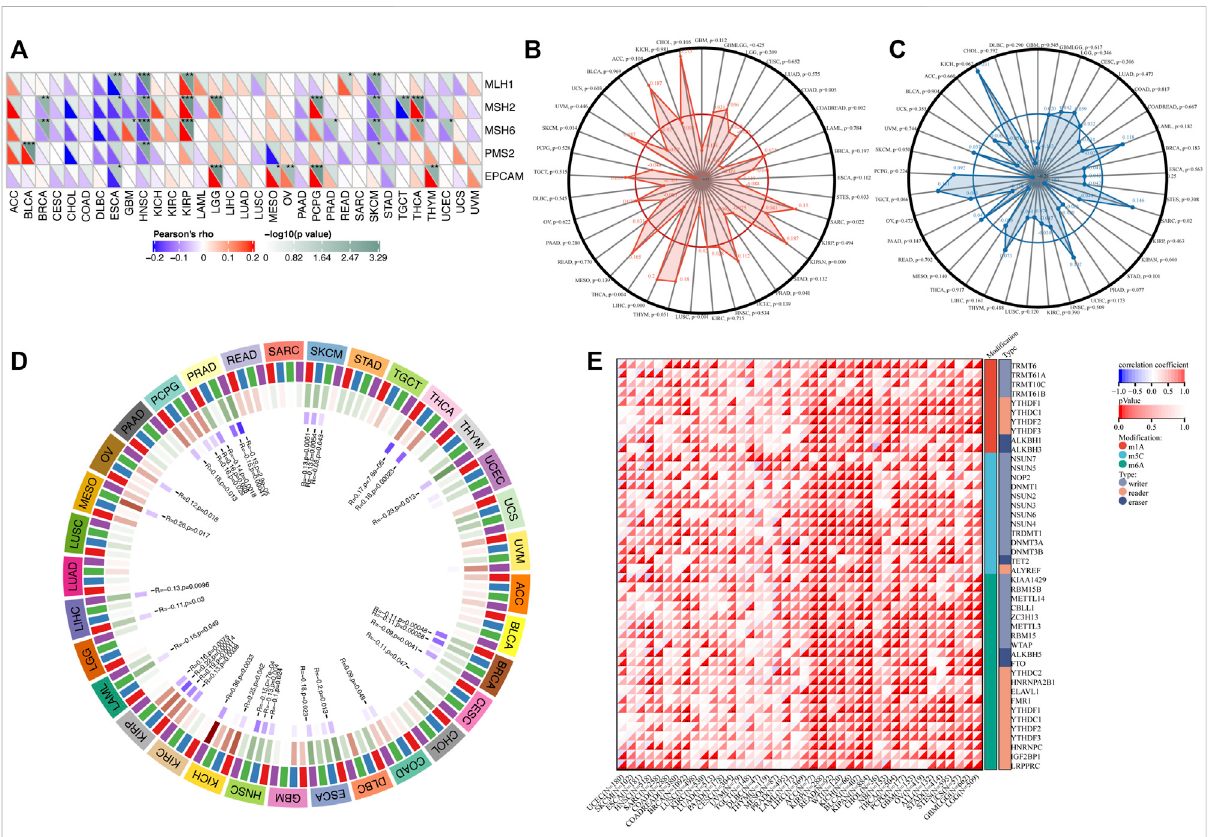
FIGURE 7 (A) Correlation between TGM3 mRNA expression and the expression of MMR genes, including MLH1, MSH2, MSH6, PMS2, and EPCAM. * p < 0.05, ** p < 0.01, and *** p < 0.001 (B) Correlation between TMB and TGM3 expression. (C) Correlation between MSI and TGM3 expression. ( p < 0.05 was considered signi fi cant). (D) Correlation between the mRNA expression level of TGM3 and those of four methyltransferases (DNMT1, red; DNMT2, blue; DNMT3A, green; and DNMT3B, purple). (E) Correlation between TGM3 and genes related to three types of RNA modi fi cations (m1A, m5C and m6A). The sloping upper triangle in each fi gure indicates the coef fi cients calculated by Spearman ’ s correlation test, and the sloping lower triangle indicates the p -value. * p < 0.05, ** p < 0.01, and *** p <